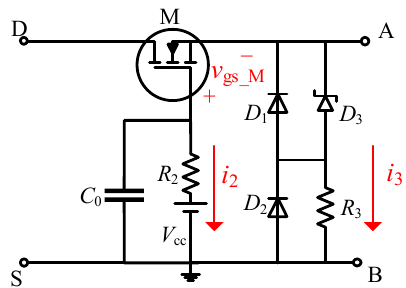
Figure 1. The schematic diagram of the conventional DVCC.